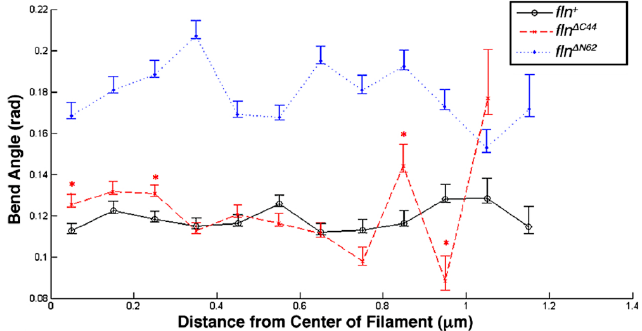
Figure 6. Mean bend angles at distances from the center of each population of thick filaments. Thick filament images were digitally folded in half, as was previously described in detail, and the mean bend angle at each distance from the center of the filament was plotted from a constant contour length of 1.2 μm, the half A-band length where flightin is distributed [20]. Bend angles at distances greater than 1.2 μm remain large, as previously noted [13]. Bend angles were significantly larger ( p > 0.05) between the amino terminal deletion and control line at all distances. Significant differences between the carboxy terminal deletion and control are indicated with an asterisk. Variation in bend angles increases at filament tips where there are fewer data tracking points available. This is especially noticeable in the carboxy terminal deletion as the filaments were shorter and had fewer representative points at the furthest distances from the center of the